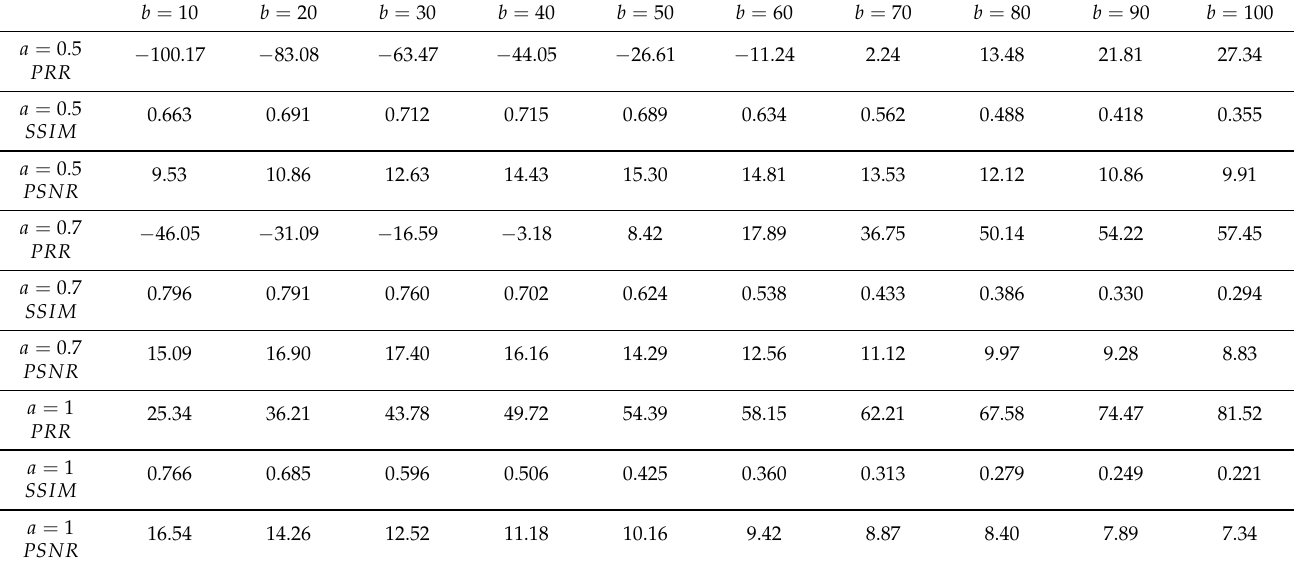
Table 10. Car image performance metrics with HE for a = { 0.5,0.7,1 } and b =